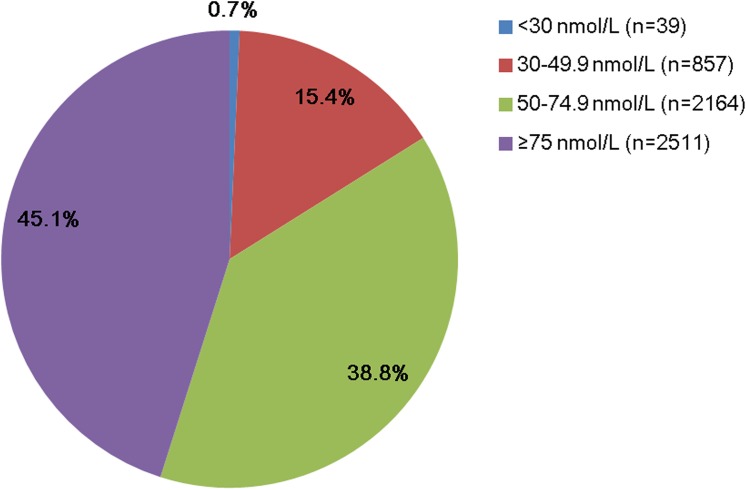
Proportion of different categories of the serum 25(OH)D level in the study population.Serum 25(OH)D levels were sectioned into four categories indicated by different color (<30 nmol/L, 30–49.9 nmol/L, 50–74.9 nmol/L and ≥75 nmol/L). n indicated children number in each category.